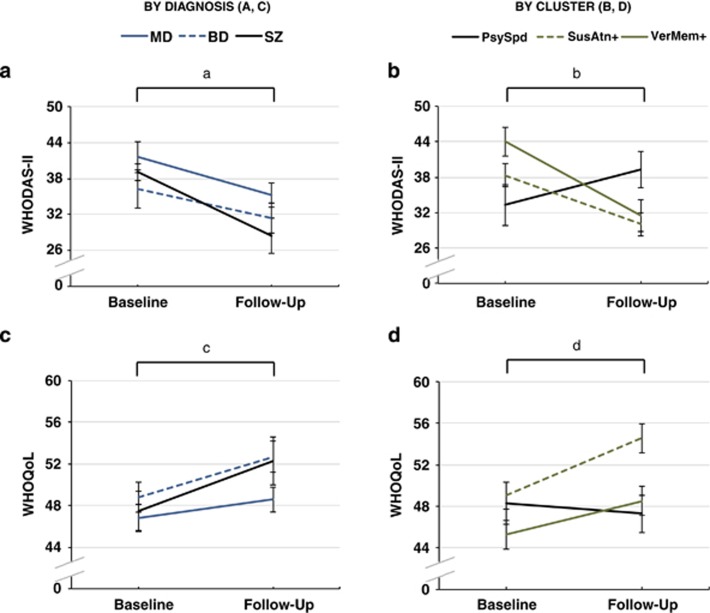
Mean baseline and follow-up WHODAS-II (a, b) and WHOQoL (c, d) scores (±s.e.). aOverall change and group × time interaction is nonsignificant (P>0.05). bOverall change is nonsignificant (P>0.05), whereas group × time interaction is significant (P<0.01). Pairwise comparisons showed that the SusAtn+ and VerMem+ clusters were each changing at significantly different rates from the PsySpd− cluster (P<0.01 and P<0.001, respectively). No other pairwise comparison was significant. cOverall change and group × time interaction is nonsignificant (P>0.05). dOverall change and group × time interaction is nonsignificant (P>0.05). WHODAS-II, World Health Organization Disability Assessment Schedule Version 2.0; WHOQoL, World Health Organization Quality of Life (BREF) Scale.